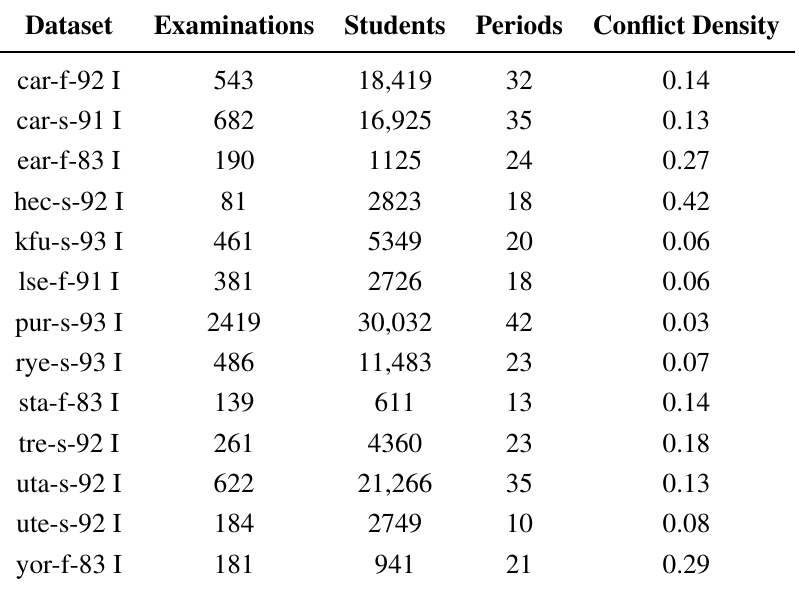
Table 1. Toronto examination timetabling problem (ETP)